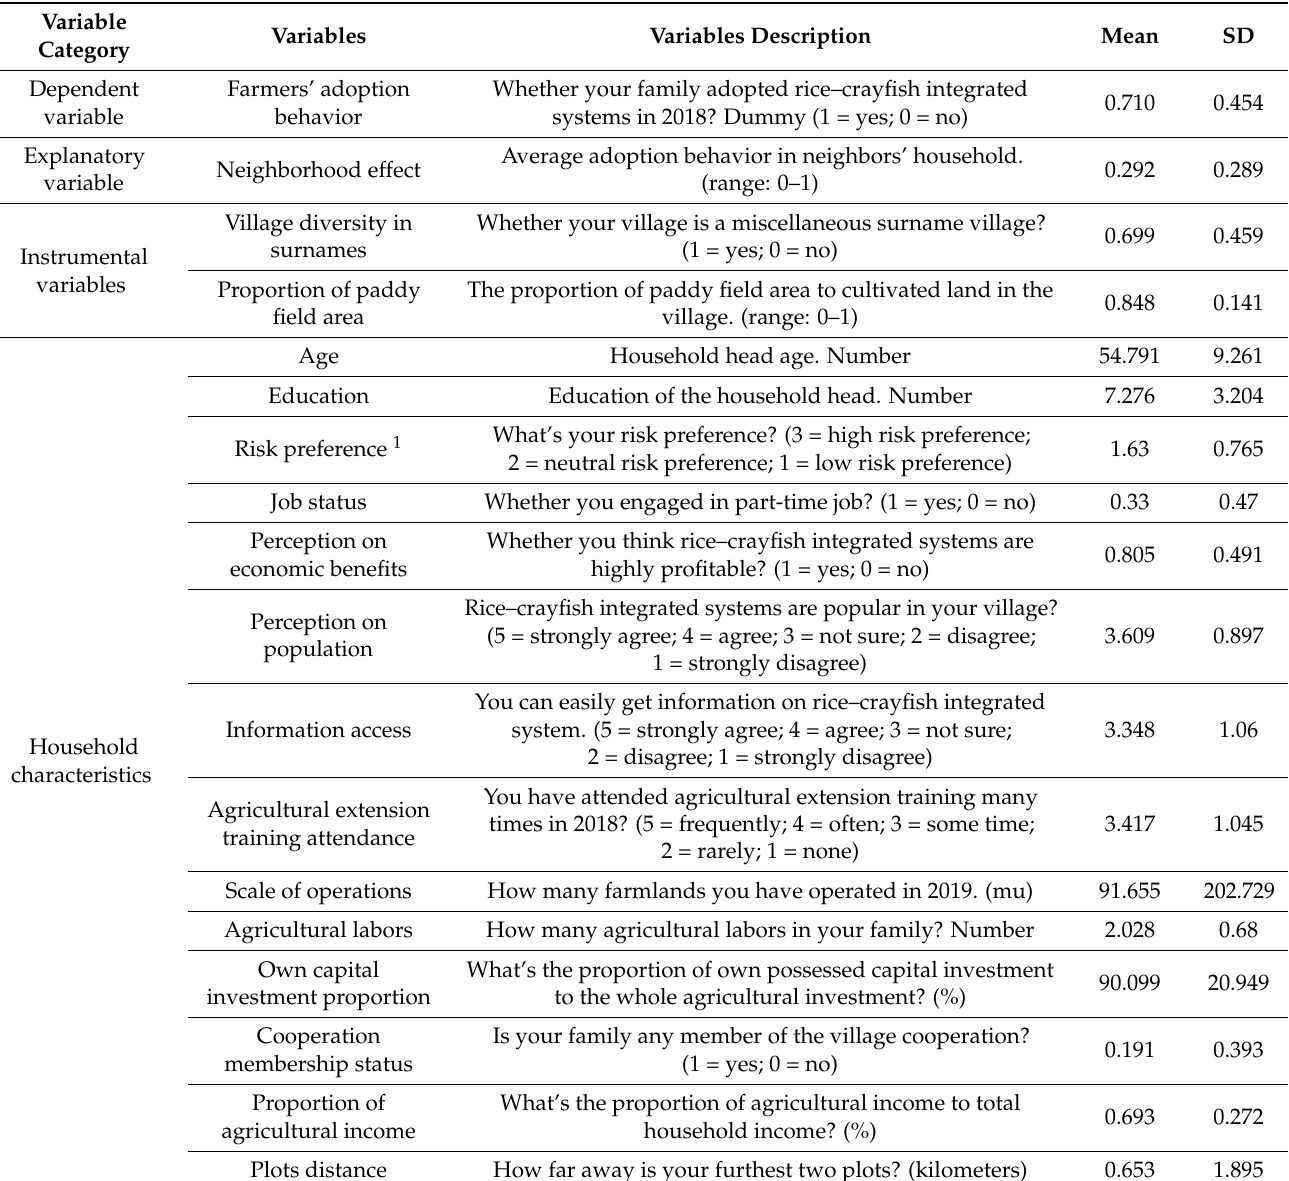
Table 1. Definition of variables and summary